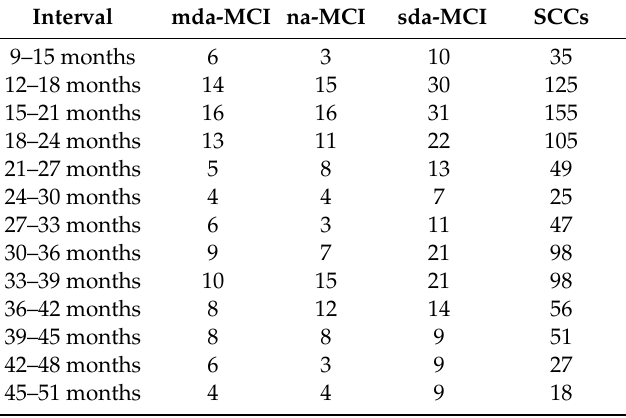
Table 2. Sample size in each overlapped time